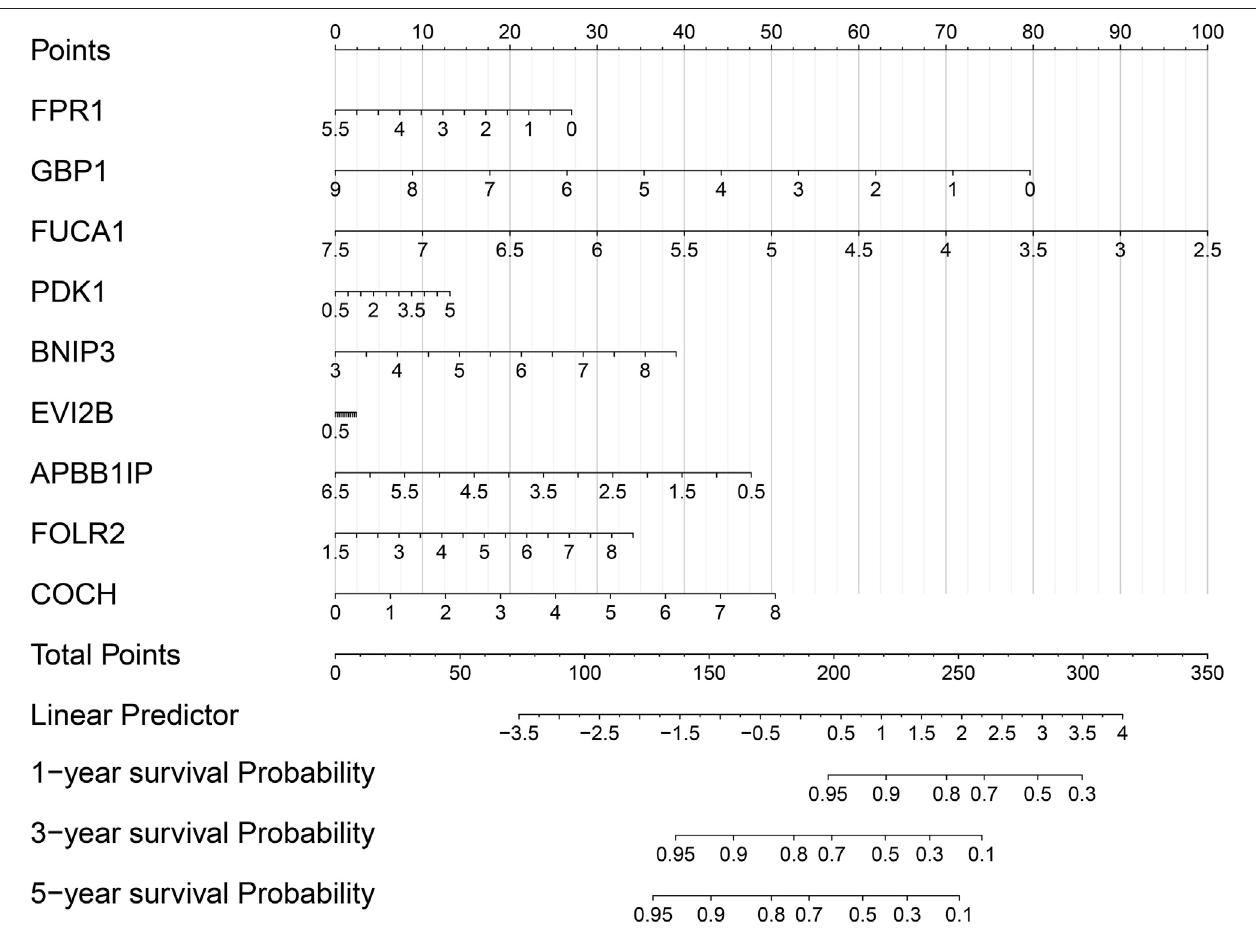
FIGURE 8 | Establishment of a nomogram for prediction of 1-, 3-, and 5-years survival of osteosarcoma in the TARGET cohort.